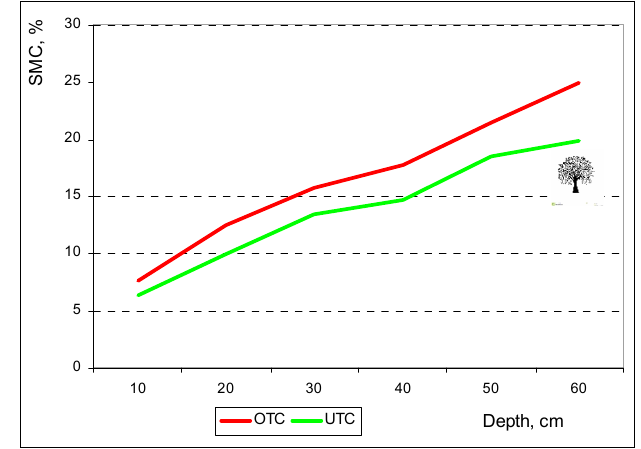
Figure 14. Soil moisture content (SMC) at different depths in April 2016, outside tree canopy (OTC) and under tree canopy (UTC).